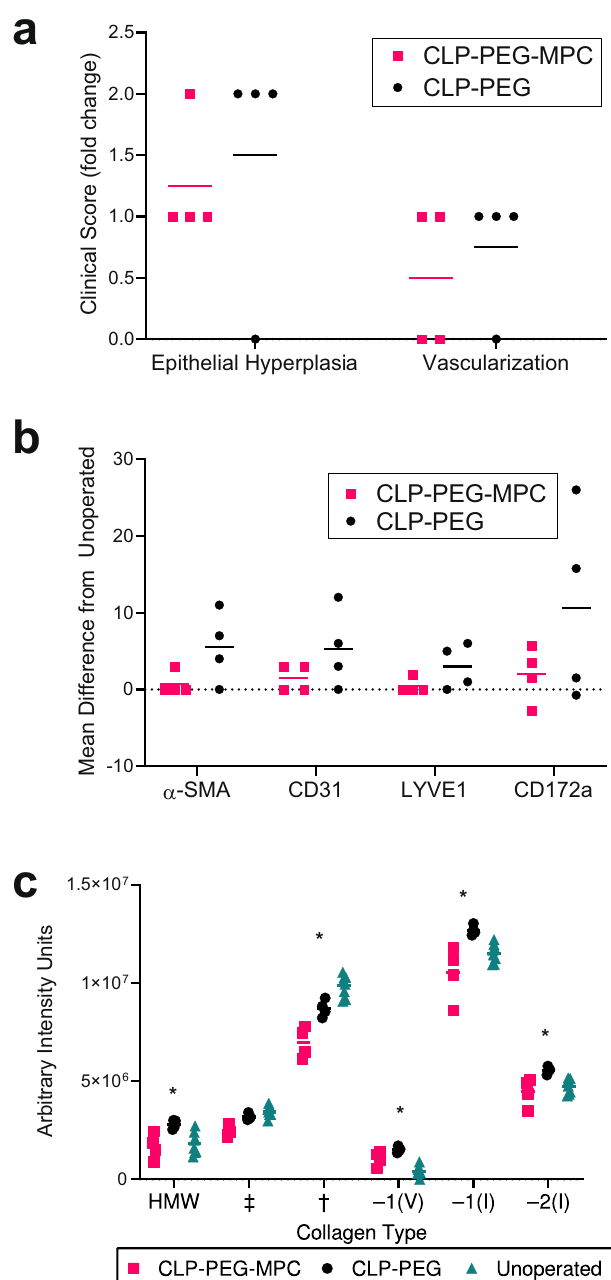
(Fig. 8a) and exosomes (Fig. 8d) compared to the unoperated control corneas (Fig. 8c, f). TEM of the corneal basement membrane showed the presence of exosomes in both grafted materials (Fig. 8g, h, j, k) but observably more copious amounts in the CLP-PEG neo-corneas.